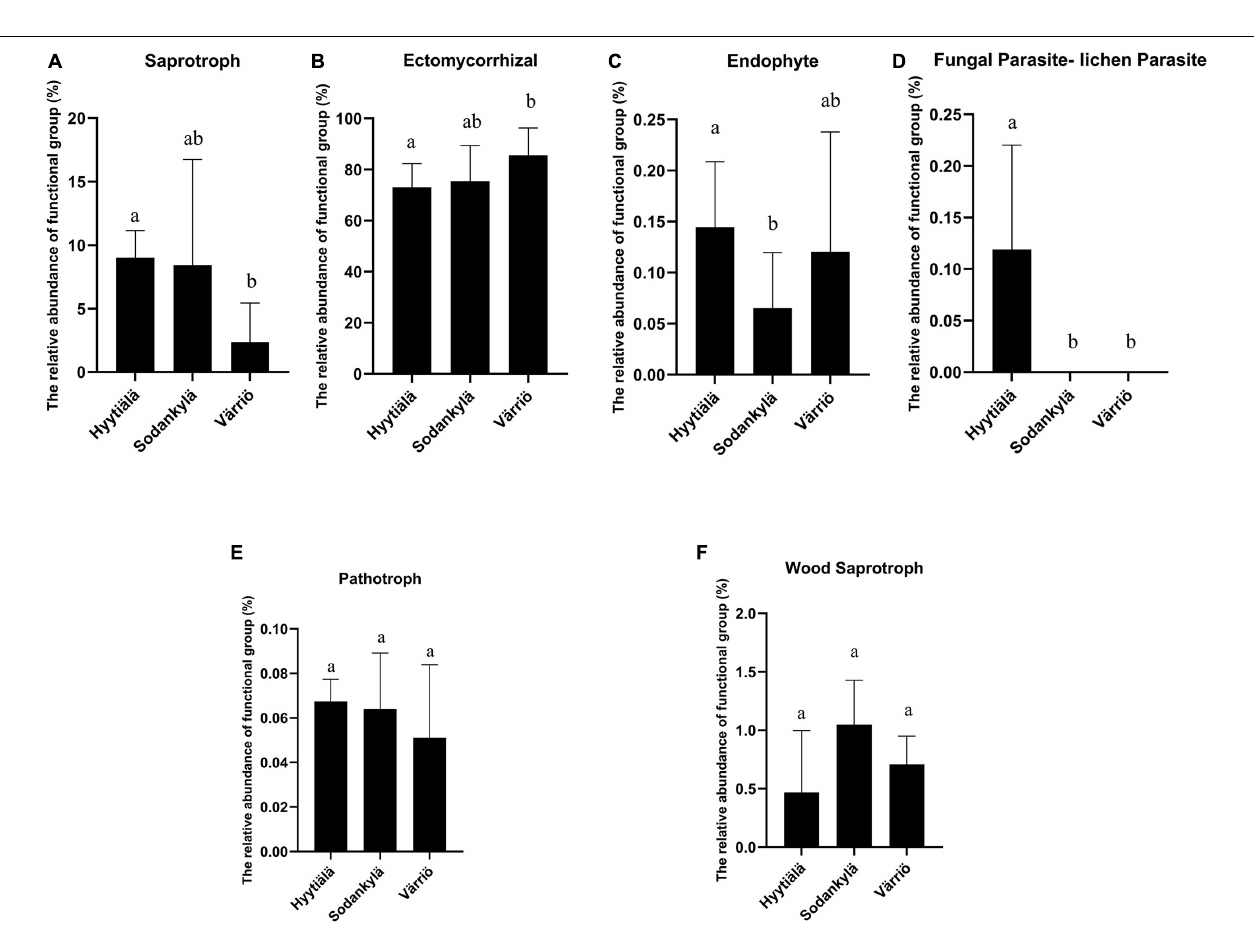
FIGURE 4 | Canonical analysis of principal (CAP) coordinates showing the fungal community structure (A) and functional structure (B) in the three locations between Hyytiälä (southern), Sodankylä (northern) and Värriö (subarctic) boreal pine forests. The list of the top 10 most abundant species was used as the explanatory variable in the functional structure. Species not shown are not significantly correlated with fungal communities.